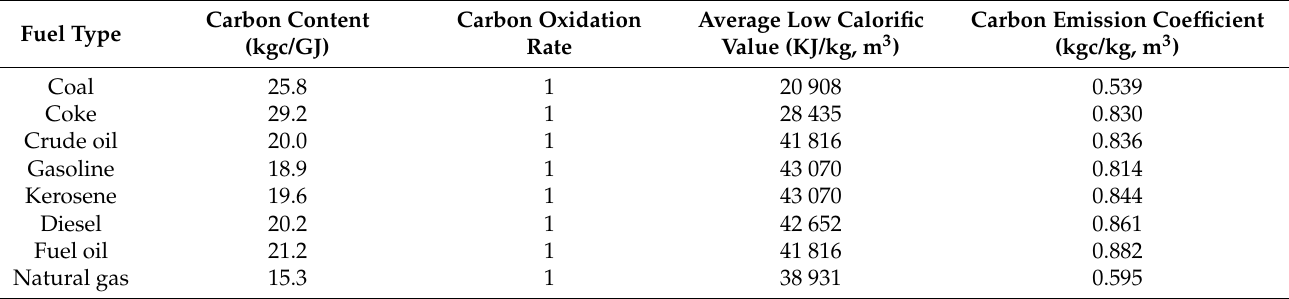
Table 1. The carbon emission coefficients of various fossil